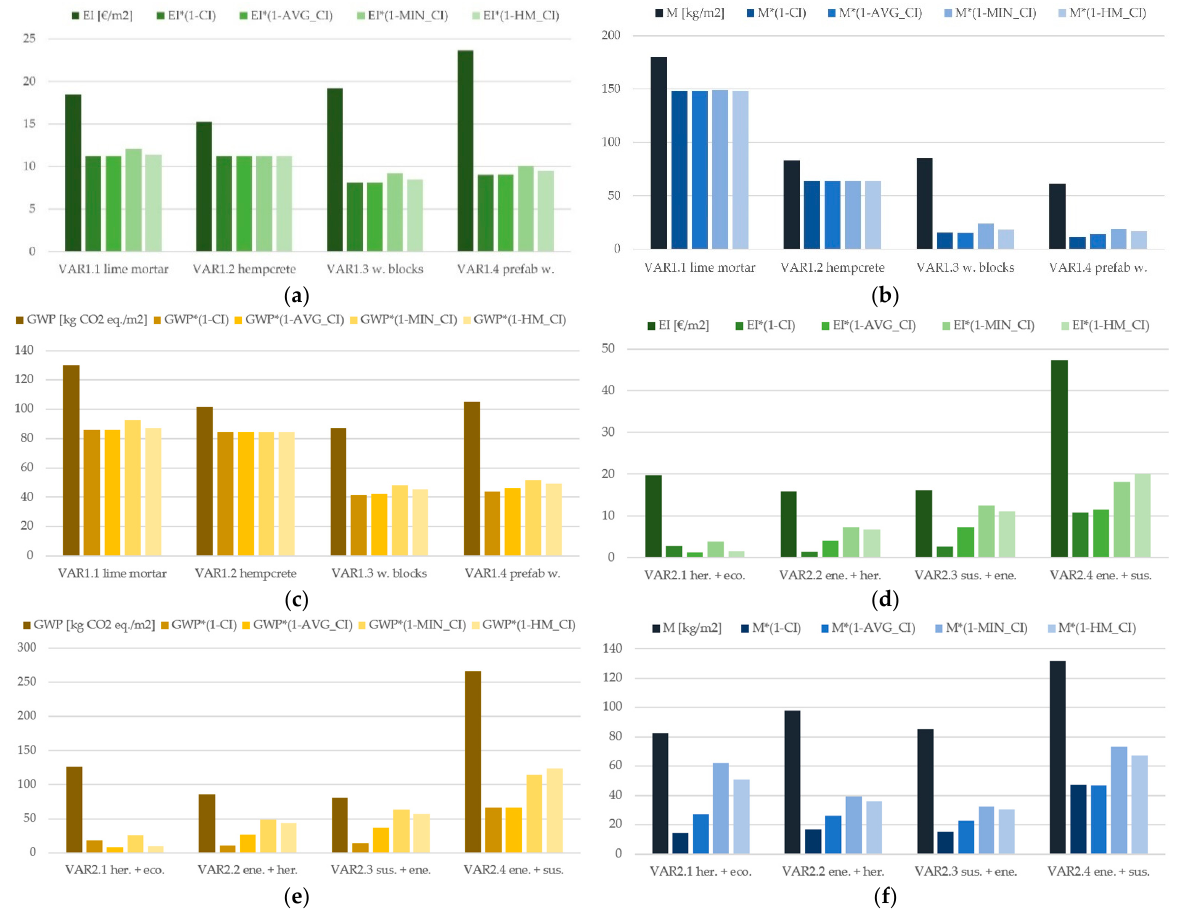
Figure 9. Results of the baseline EI and linked EI’ (green bar charts), baseline GWP and linked GWP’ (yellow bar charts), and baseline M and linked M’ (blue bar charts) of all external wall variants of both case studies, grouped per external wall variant. The left bar of each external wall variant represents the baseline reference, and the remaining four bars represent the four linked results. ( a ) EI and four possible EI’ of case study 1. ( b ) GWP and four possible GWP’ of case study 1. ( c ) M and four possible M’ of case study 1. ( d ) EI and four possible EI’ of case study 2. ( e ) GWP and four possible GWP’ of case study 2. ( f ) M and four possible M’ of case study 2. Table 7. Linked EI, GWP and M results of all external wall variants for all four linking options, in absolute values and in relative difference to the baseline.